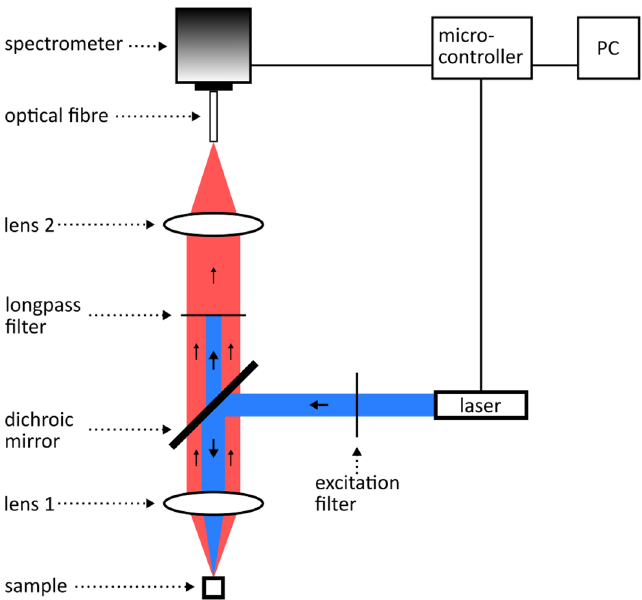
Figure 7. Illustration of our PL spectroscopy setup. The excitation light follows the path highlighted in blue to induce PL on the sample. The pathway of the PL signal is highlighted in